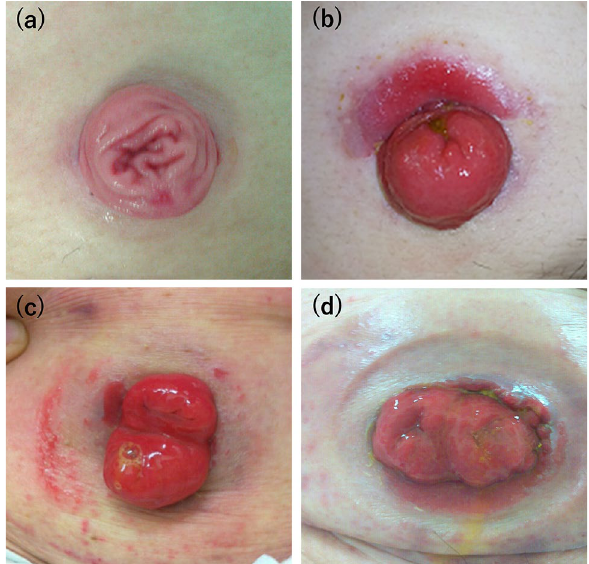
Figure 1. Peristomal skin disorders diagnosed according to the ABCD-stoma score. ( a ) Normal skin around stoma (score: 0, non-peristomal skin disorder). ( b ) Erosion on the upper side of the area near the stoma, where the skin barrier has dissolved (score: 2, non-severe peristomal skin disorder). ( c ) Erosion on the right side of the area near the stoma, where the skin barrier has dissolved. Erosion is observed in the region contacting the ostomy appliance (score: 4, severe peristomal skin disorder). ( d ) Ulcer and erosion on the area near the stoma, where the skin barrier has dissolved. Erythema is observed in the region contacting the ostomy appliance (score: 16, severe peristomal skin